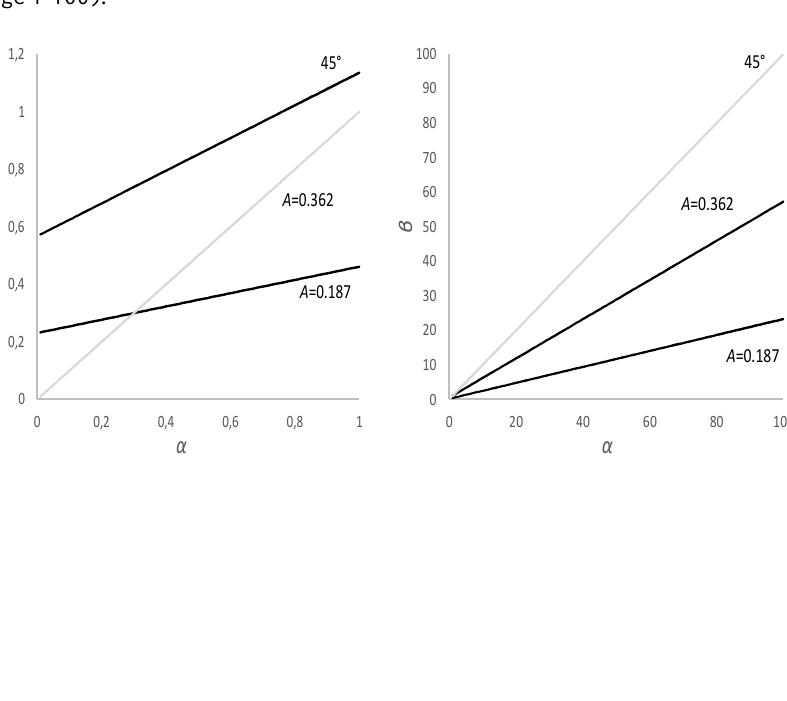
Figure 2. The relation between (cid:9) and (cid:10) for the 2+1 family ( (cid:9) range 0-1) and ( (cid:9) range